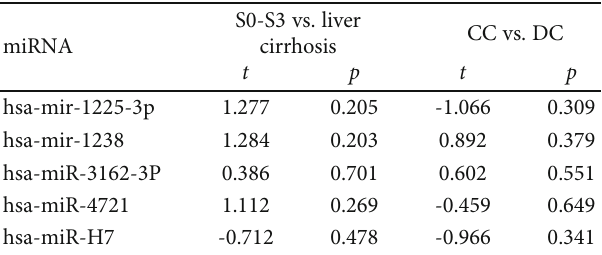
Table 5: p values of miRNA expression in the CHB liver fi brosis group, liver cirrhosis group, compensated cirrhosis group, and decompensated cirrhosis group. S0-S3 vs. liver CC vs. miRNA cirrhosis